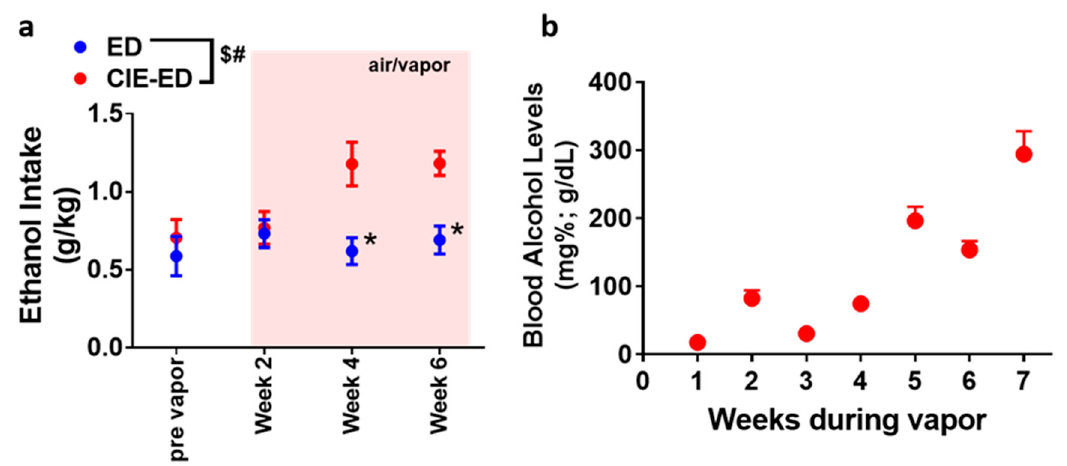
Figure 2. Ethanol self-administration and blood alcohol levels. ( a ) Amount of ethanol consumed prior to chronic intermittent ethanol (CIE) initiation and over the 6 weeks period of CIE or air exposure. Weeks of air/vapor exposure are indicated over a pale pink background. ( b ) Blood alcohol levels measured once a week in animals experiencing CIE. CIE-ED, n = 7 and ED, n = 8. $, interaction; #, main effect of groups; * p < 0.05 vs. CIE ‐ ED by two ‐ way analysis of variance (ANOVA). Data are expressed as mean ± S.E.M.